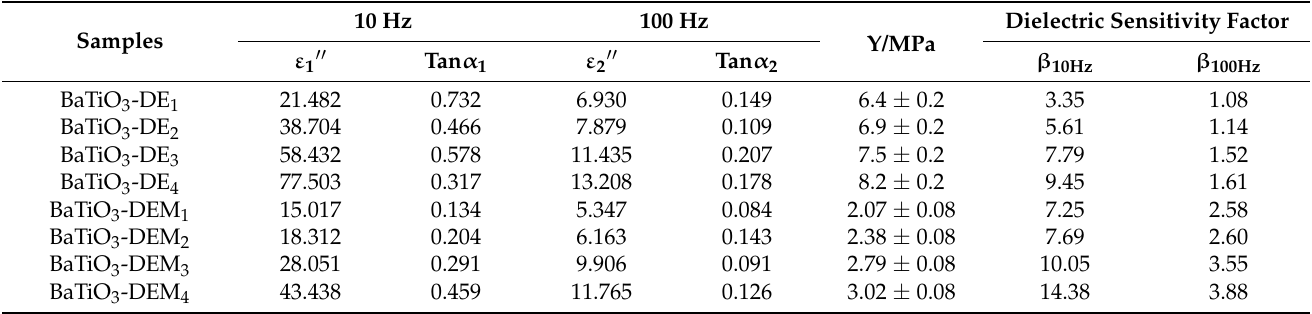
Table 7. Dielectric properties and sensitivity factors between two kinds of samples.